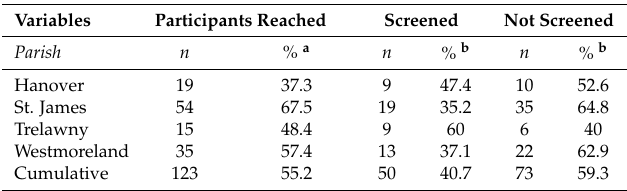
Table 5. Cervical cancer screening rates.